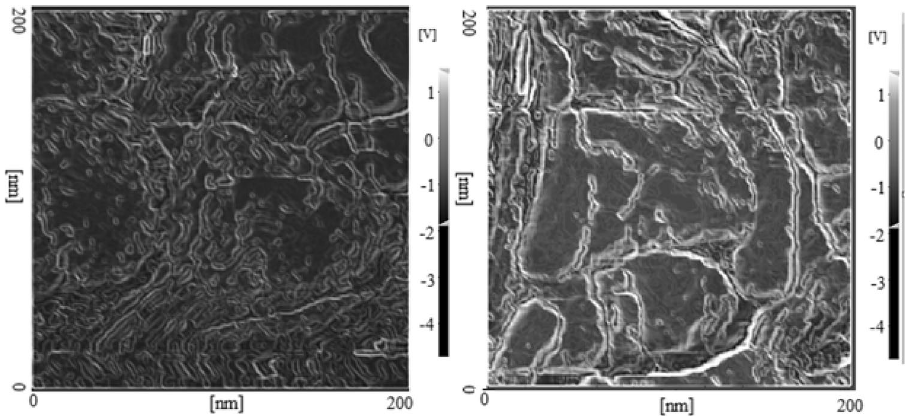
Figure 3. HR-AFM images of conjugated/unconjugated Salen-based polymer as conductive